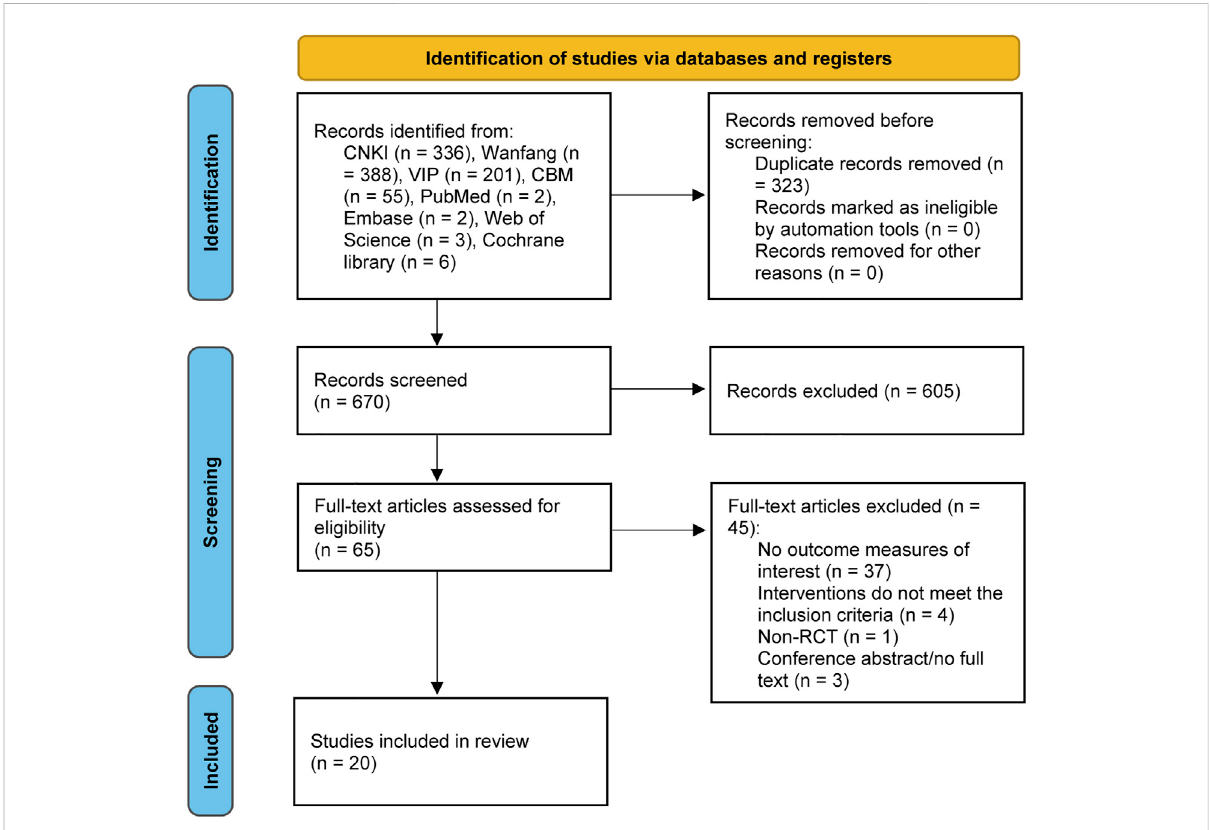
FIGURE 1 PRISMA fl ow diagram of literature selection and identi fi cation. PRISMA, Preferred reporting items for systematic reviews and